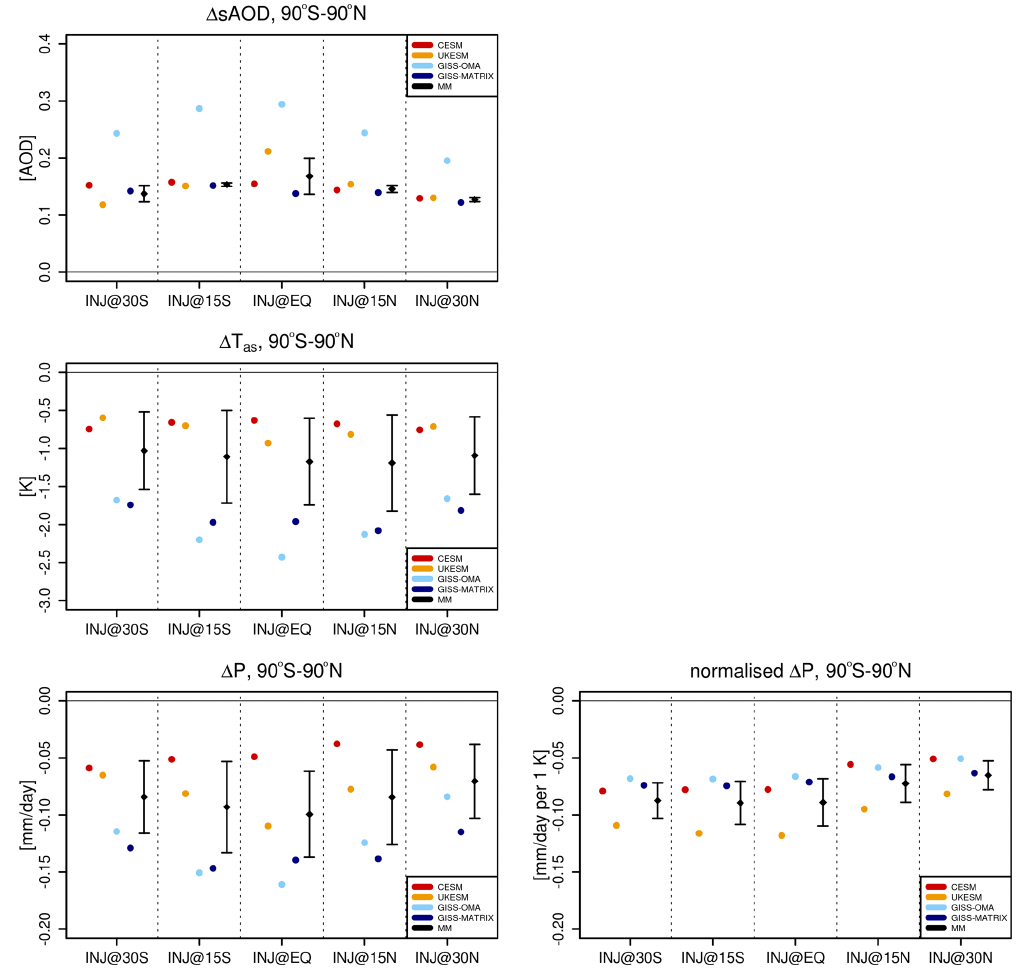
Figure 13. As in Fig. 12 but for changes in global mean (top to bottom): stratospheric aerosol optical depth (AOD), surface temperature, and